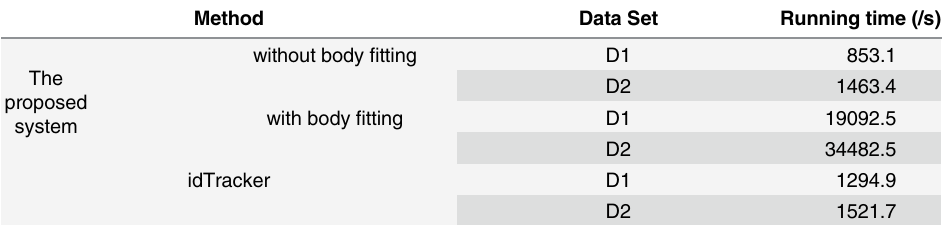
Table 4. Running time of the proposed system and idTracker.